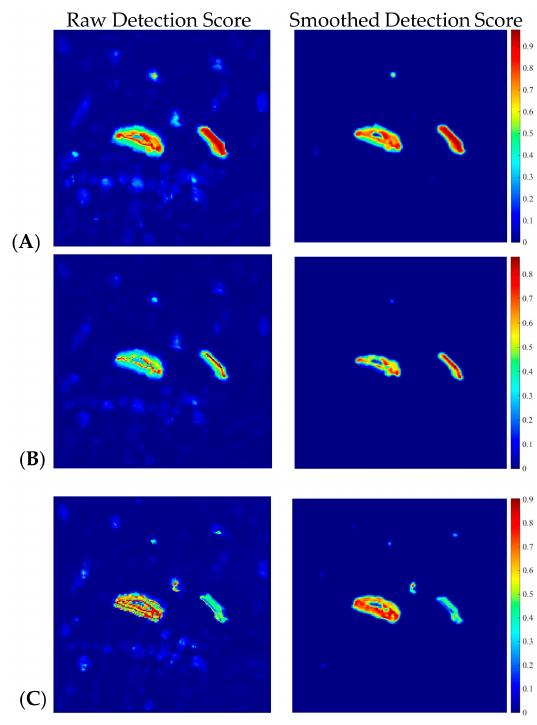
Figure 5. The target detection score. ( A ) DM calculated with all of the image data. ( B ) DM calculated with sampled image data, where the random sampling rate is 0.8. ( C ) DM calculated with sampled image data, where the random sampling rate is 0.2.